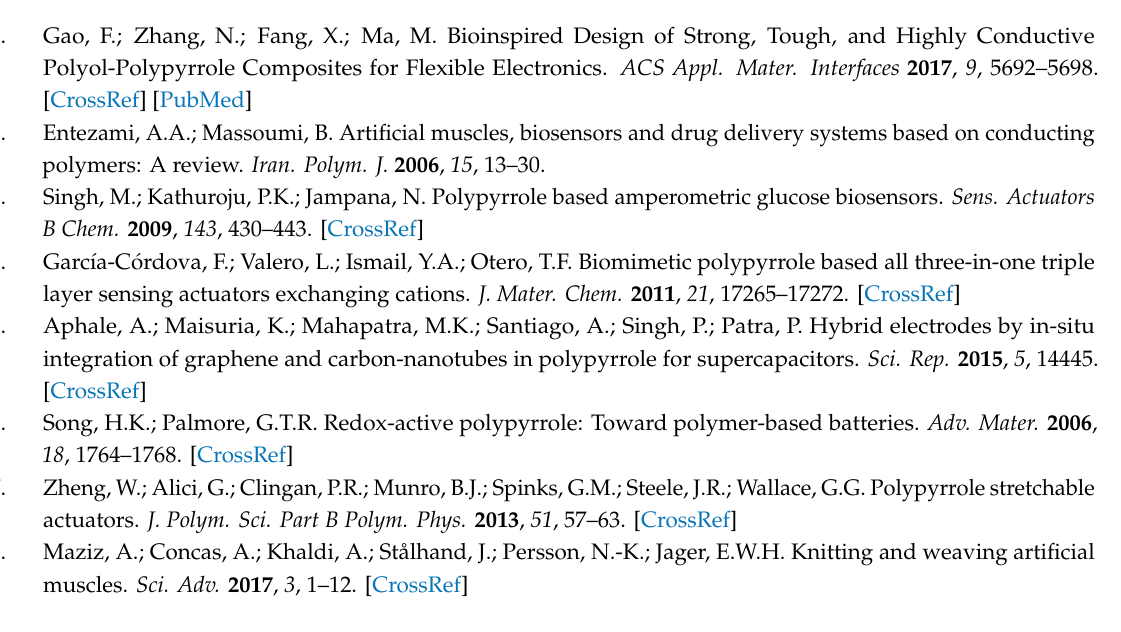
Figure S1: Synthesis of 1-vinyl-3 hexylimidazolium bromide (C6VImBr), Figure S2: Anion exchange of PIL monomers C6VImBr to C6VImTFSI, Figure S3: Setup of mSICM in (a) Scheme of mSICM with samples (PPyPIL films in electrolyte) connected as working electrode (WE) with additional reference electrode (Ag / AgCl wire, RE). The micro-pipette can be positioned by a piezo actuator and contains the electrolyte, with the counter-electrode (CE, Pt wire) connected over the electrolyte droplet to the samples. (b) Picture of the mSICM measurement set up with included CCD camera to fix the micropipette to the sample, and a light source, Figure S4: Chronopotentiogram of PIL synthesis, Figure S5: Structure of the proposed PPyPIL blends formed during electropolymerization of pyrrole and PIL monomer in PC with “R” representing the hexyl chain, Figure S6: Cyclic voltammetry (5 mV s − 1 , 3rd cycle) measurements of PPyPIL films in LiTFSI-aq (solid line) and LiTFSI-PC (dotted) electrolytes (3 electrode cell: the PPyPIL sample as working electrode, a platinum sheet counter electrode and a Ag / AgCl (3 M KCl) reference electrode) at potential range 0.65 to − 0.2 V. The current density (j) curves vs. potential E are shown in (a) and the charge density Q vs. potential E are presented at (b). The arrows indicate the start and ending point of the cycles, Figure S7: Square wave potential step measurements of PPyPIL films showing in (a) the current density time curves in LiTFSI-PC (line) and LiTFSI-aq (dotted) electrolytes in potential range 0.65 to − 0.2 V (dashed line) at frequency of 0.0025 Hz (2nd and 3rd cycles). The di ff usion coe ffi cients D red at reduction calculated from Equation (1) and (2) are shown in (b) of PPyPIL films in LiTFSI-PC ( (cid:3) , dotted line as orientation) and LiTFSI-aq ( (cid:73) , dashed line as orientation) at applied frequencies 0.0025 Hz to 0.1